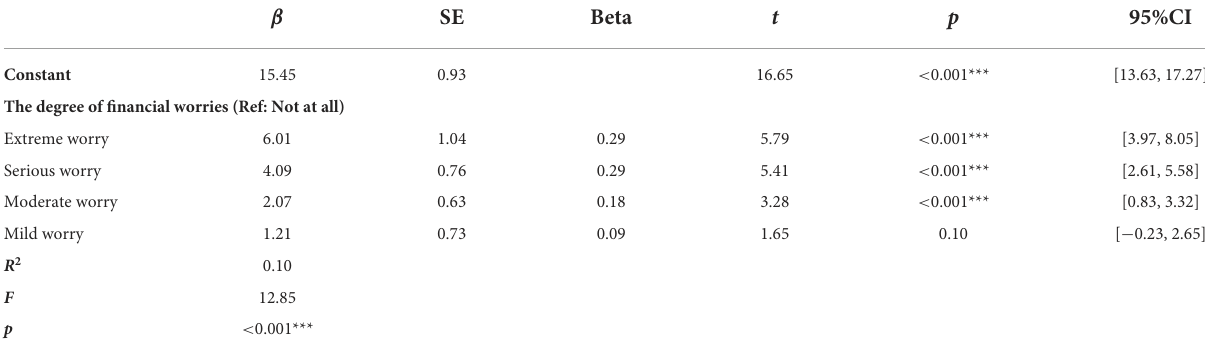
TABLE 6 Multiple linear regression analysis on behavioral